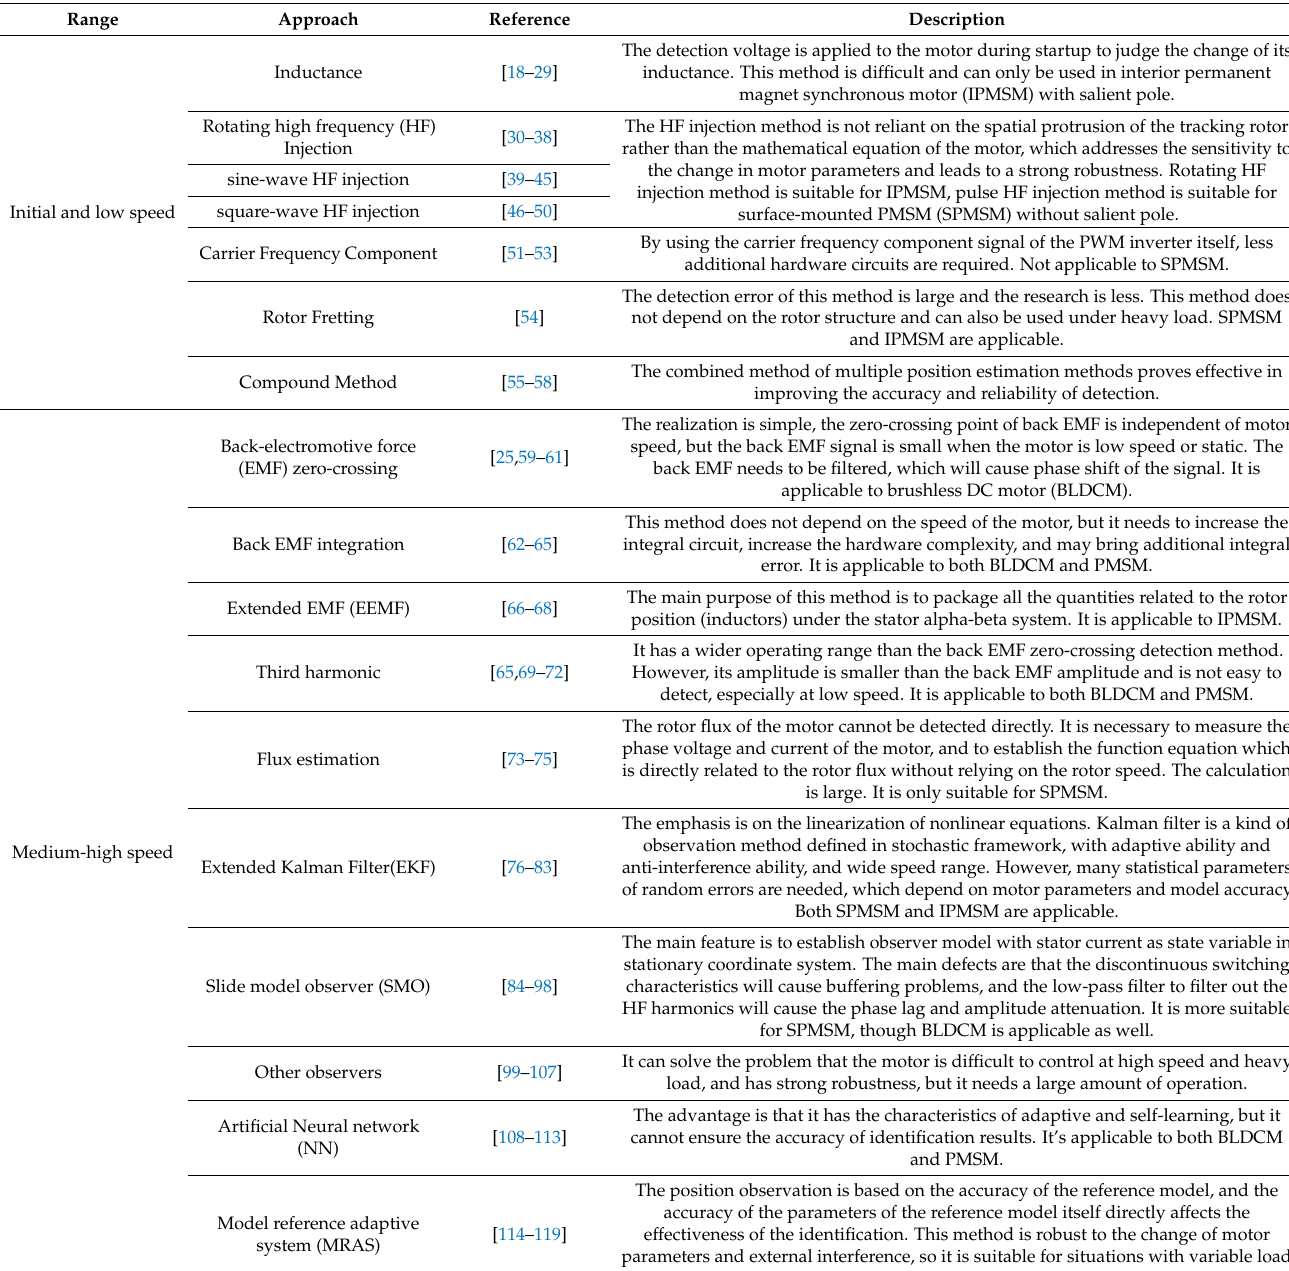
Table 1. Position detection